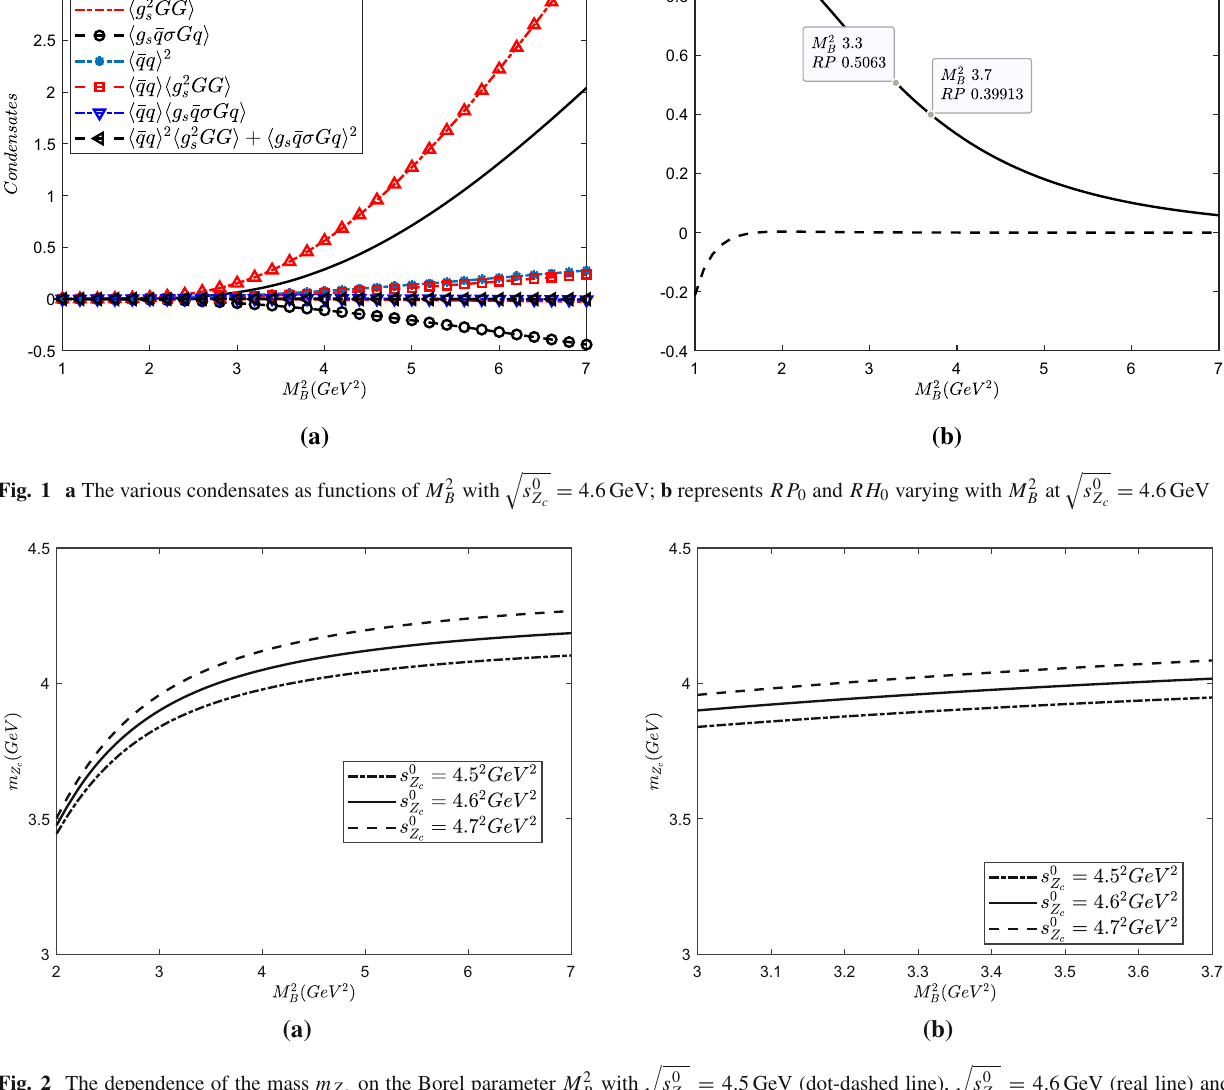
on the Borel parameter M 2 c